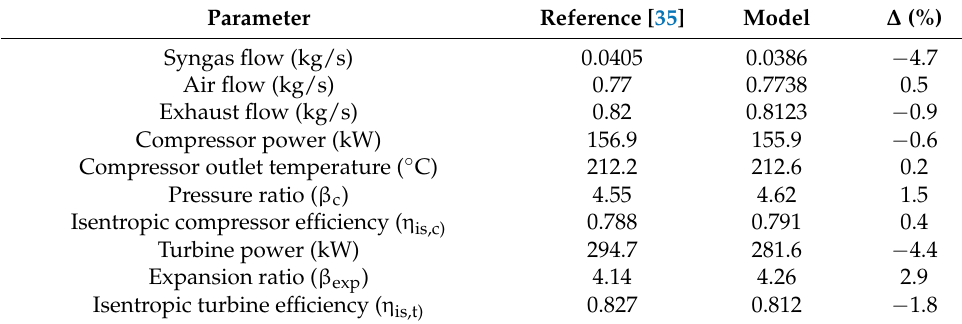
Table 4. Model validation with syngas feeding at the rated